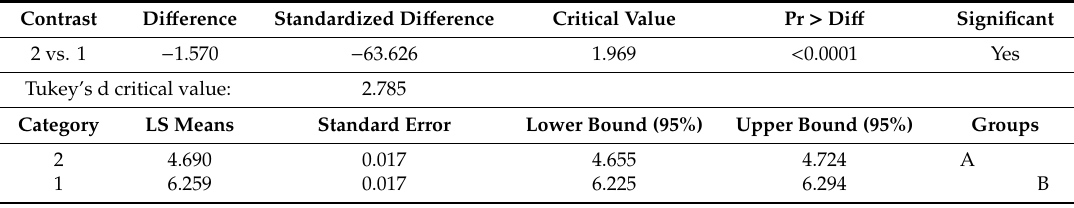
Table 6. Tukey’s HSD test results for the saccharinic acids yield (g / L). Analysis of the di ff erences between the two reaction media with a confidence interval of 95%. “1” stands for the pretreatment medium with sulfolane-TiO 2 and “2” for the medium without